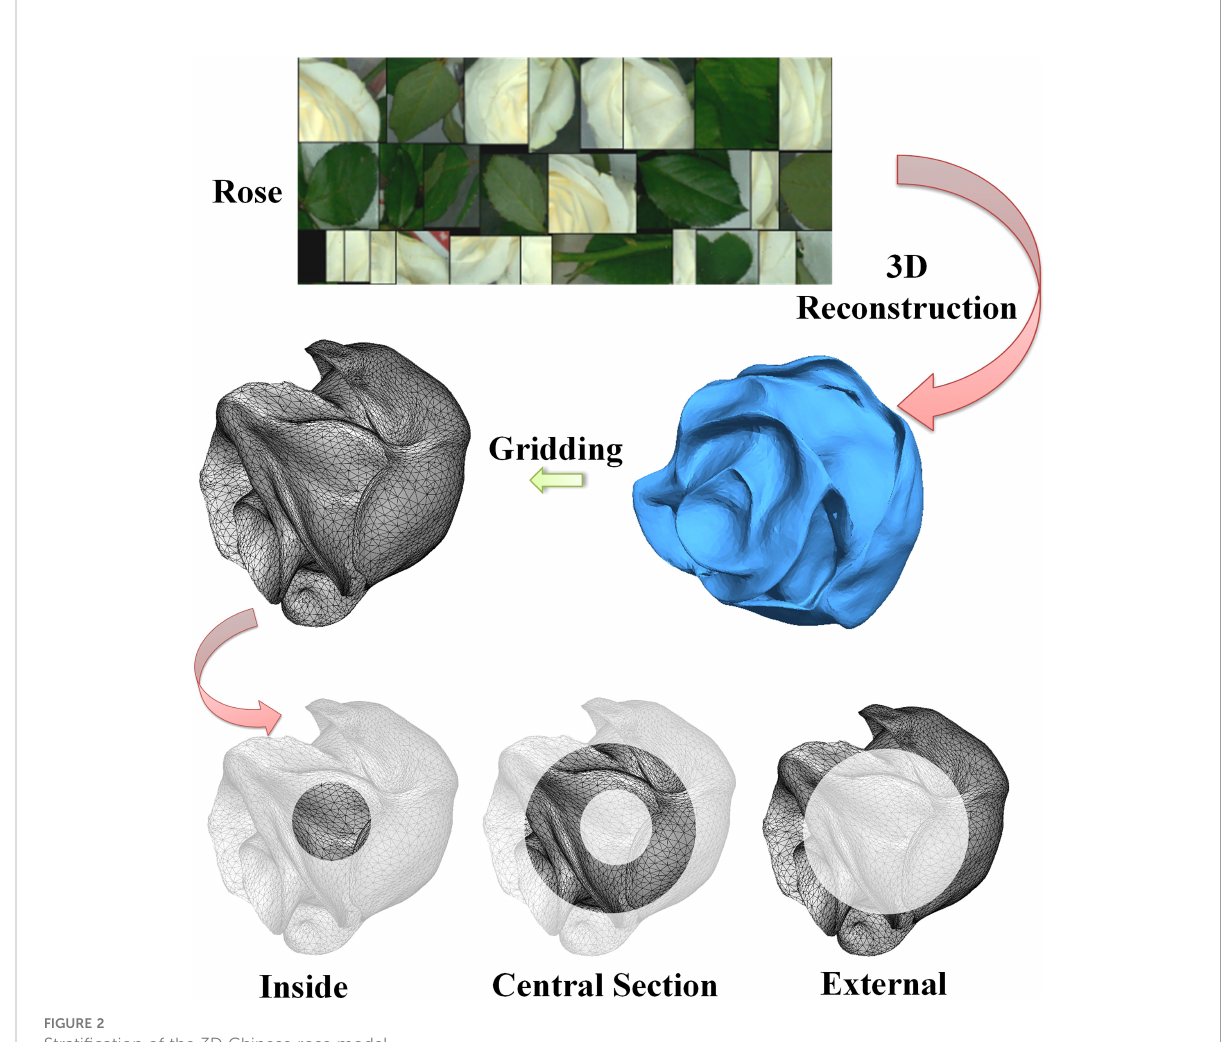
FIGURE 2 Strati fi cation of the 3D Chinese rose